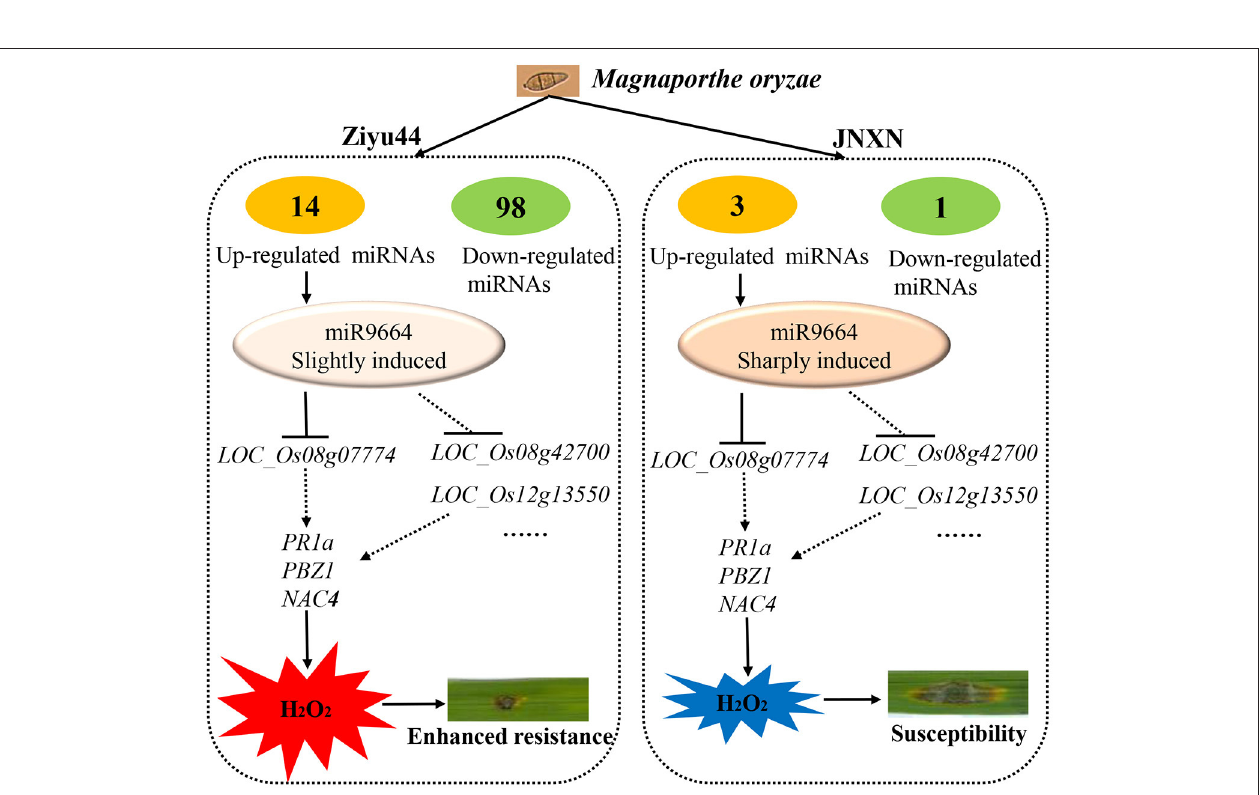
FIGURE 8 | differences ( P < 0.01). Similar results were obtained from the three independent experiments. (B) 5 ′ -RACE assays showing the cleavage sites within miR9664 target regions of the target genes LOC_Os08g07774 . The cleavage site is shown with a black arrow, 10 out of 17 monoclonal sequencings showed the same results. The predicted CC, NBS, and LRR domains encoded by the target genes are labeled. N and C represent the amino and carboxyl terminals of R proteins, respectively. aa, amino acid.